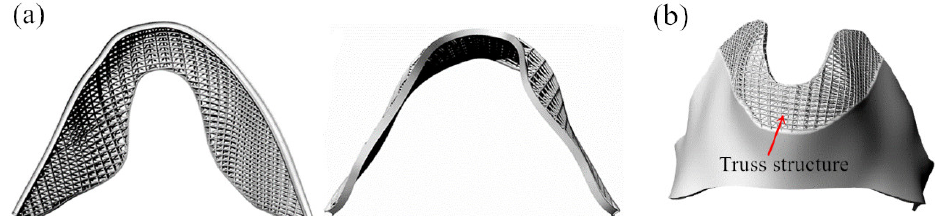
Figure 7. Total removal of multi-layer mesh of thyroid cartilage prosthesis after removal of convex points. ( a ) Convex points elimination effect; ( b ) Matching effect.